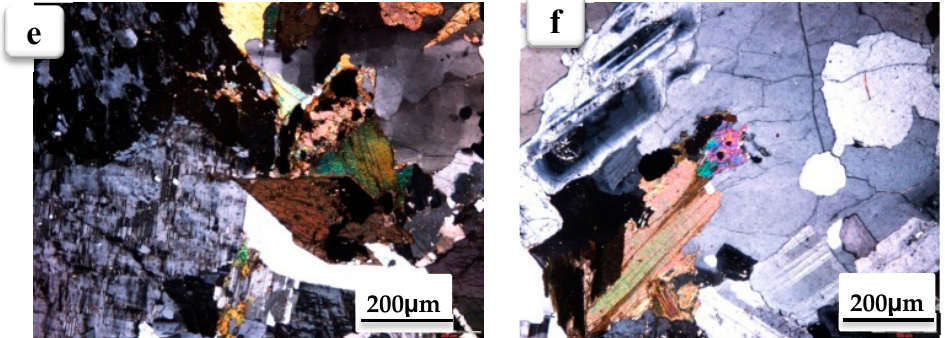
Figure 4. Photomicrographs for Aswan granite showing: ( a ) Deformed crystal of zircon associating biotite, hornblende and quartz, CN; ( b ) euhedral crystal of zircon in BI, CN; ( c ) zoned crystal of metamict allanite associating perthite, plagioclase, and opaque, CN; ( d ) well-formed crystals of titanite with prismatic and sphenoidal forms (sphene), CN; ( e ) well-formed crystals of titanite with sphenoidal forms (sphene) associating antiperthite, CN; ( f ) secondary epidote associating plagioclase and quartz, CN.